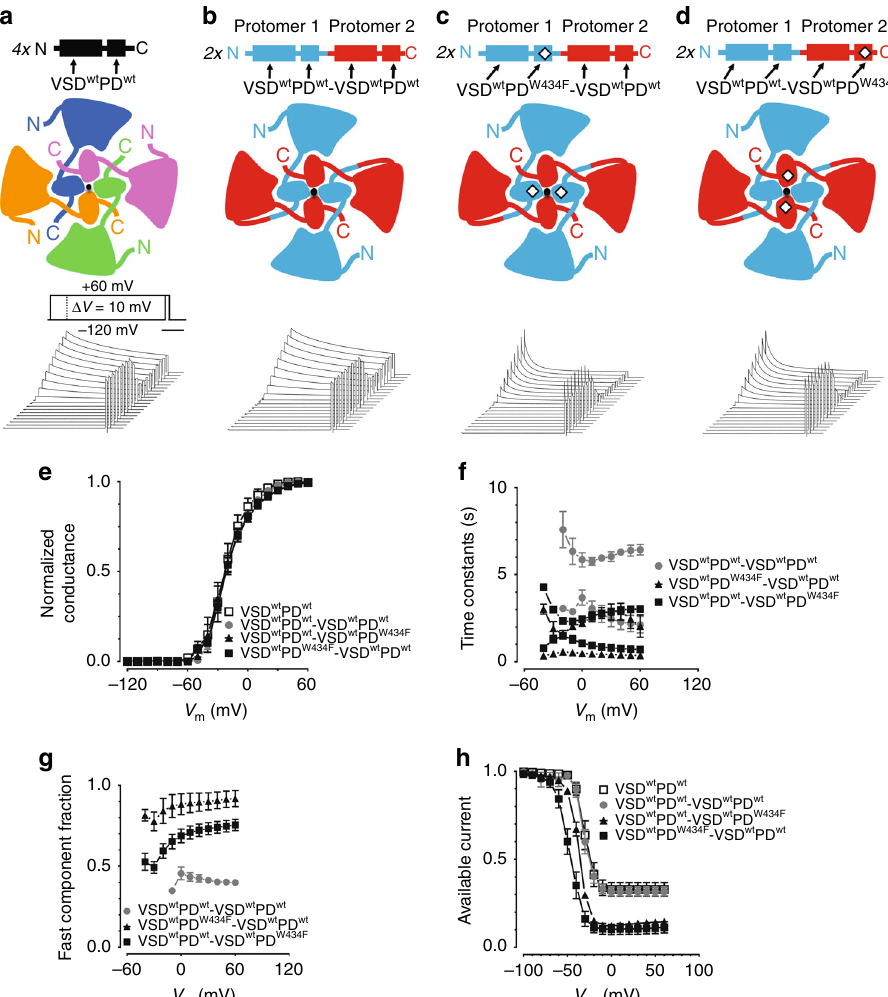
Fig. 1 Biophysical properties of Shaker dimers when mutated in PDs. a Top: representation of Shaker protein showing wild-type voltage sensor (VSD wt ) and pore domains (PD wt ); Middle: Top view of Shaker channel in the membrane, showing each subunit (protein) of the tetramer represented by a different color, with N and C representing amino-terminus and carboxy-terminus, respectively. The black circle in the center represents K + ions within the conductive pathway. Bottom: Typical K + currents from Shaker channels expressed in Xenopus oocytes with the indicated voltage protocol. Horizontal bar means 2 s. b Top and middle: schematics showing dimerized Shaker, with protomer 1 in blue and protomer 2 in red. These channels do not contain W434F mutations and are called wt-PD Shaker dimers. Bottom: K + currents recorded from wt-PD Shaker dimers in similar condition as in a . c , d Top and middle: representation of Shaker dimers containing the mutation W434F (W434F-Shaker dimers) in protomer 1 in c and in protomer 2 in d . The mutant domains are marked by a diamond. Bottom: K + currents recorded with the respective channels in similar conditions as in a . In e – h , open squares are for Shaker, gray circles for wt-PD Shaker dimers, black triangles, and black squares for W434F-Shaker dimers with W434F mutation in protomers 1 and 2, respectively. e Normalized conductance – voltage ( G – V ) curves for the channels represented in a – d . f Time constants of the K + currents inactivation in the indicated channels during 10 s depolarizing voltages periods (same protocol shown in a , bottom, and same symbols convention as in e ). Fast and slow time constants from two exponentials fi t to the data (see “ methods ” section for details), are shown for all Shaker dimers as in b – d . g Fast component relative amplitude of the exponential components in the channels indicated. h K + currents 10 s inactivation curves (Inact- V ) in the channels indicated. All data points are the average of 4 – 6 independent experiments. The vertical bars in e – h are the standard error of the mean. VSD wt PD wt : Shaker; VSD wt PD wt -VSD wt PD wt :